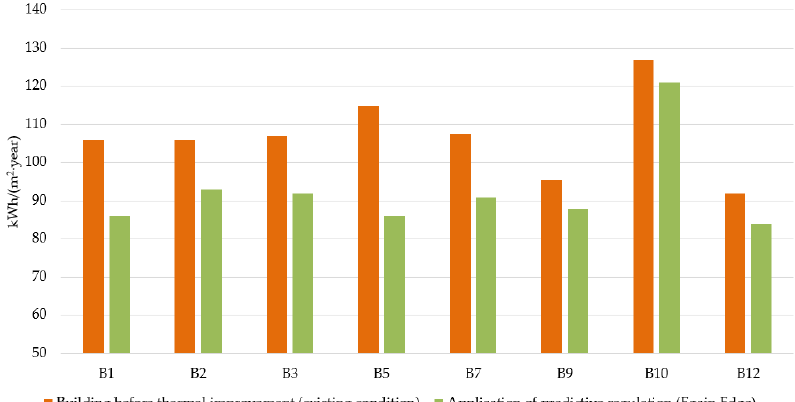
Figure 8. Reduction in energy consumption for central heating after using predictive control system (Egain Edge) without thermal improvement of the building.